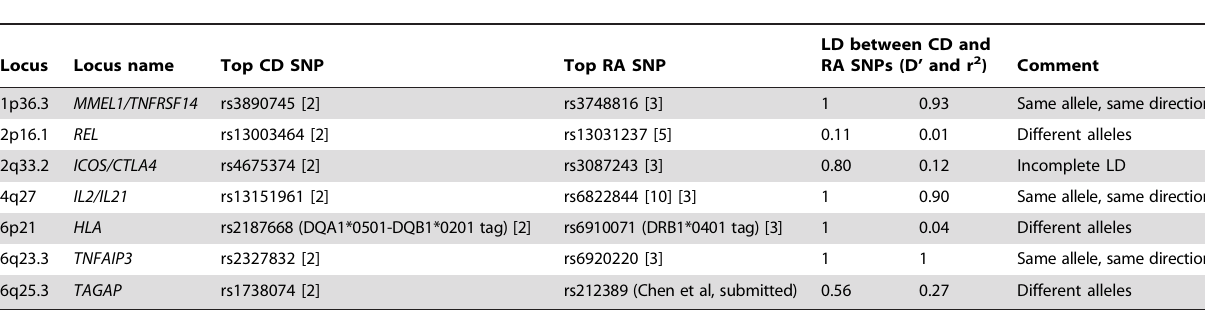
Table 1. Comparison of CD and RA risk alleles at seven shared risk loci.